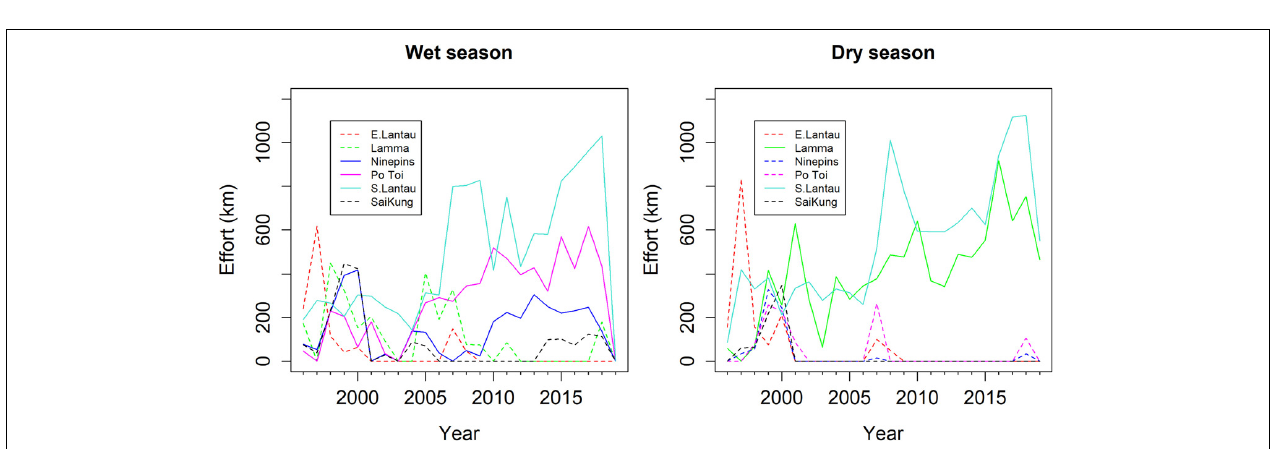
FIGURE 3 | Survey effort by month, showing relatively consistent effort throughout the year. The dry season is winter to spring (December to May) and the wet season is summer to fall (June to November).